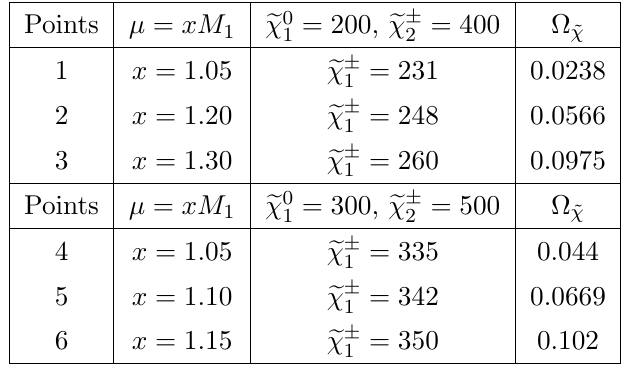
Table 20 . DM relic densities for two di(cid:11)erent masses are in